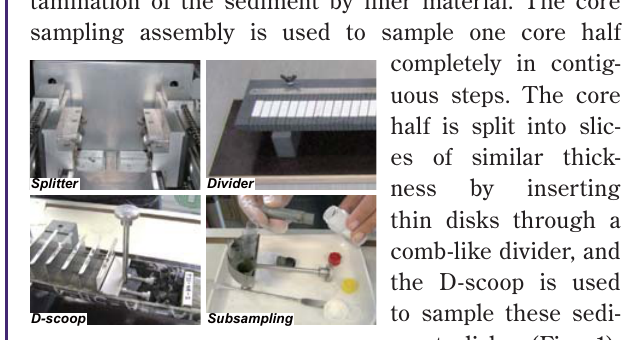
Figure 1. Photographs of core splitter and the sledges with the four blades, divider, and the